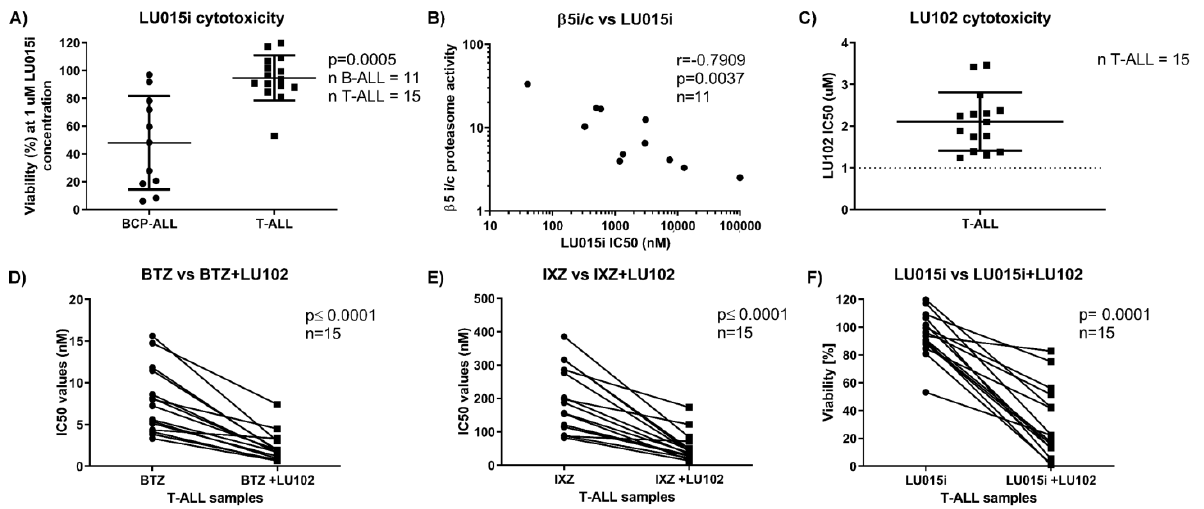
Figure 3. Cytotoxicity of subunit-selective proteasome inhibitors in BCP-ALL and T-ALL and correlation with immunoproteasome activity. ( A ) Comparison of the cytotoxicity of LU015i between BCP-ALL and T-ALL samples, p was obtained with Mann–Whitney U test. ( B ) Correlation between the ratio of activity of proteasome β 5i versus β 5c, determined by ABPs, and cytotoxicity of LU015i in BCP-ALL, expressed as individual IC 50 values. r and p were obtained with Spearman’s correlation. ( C ) IC 50 values of LU102 in T-ALL samples. ( D ) Paired comparison of IC 50 values of BTZ alone or combined with fixed dose of LU102 (1 µ M) determined 48 h after the continuous treatment in T-ALL. p was obtained with Wilcoxon’s paired test. ( E ) Paired comparison of IC 50 values of IXZ alone or combined with fixed dose of LU102 (1 µ M) determined 48 h after the continuous treatment in T-ALL. p was obtained with Wilcoxon’s paired test. ( F ) Cell viability (normalized to untreated control cells as 100%) in T-ALL after 48 h treatment with 1 µ M LU015i alone or in combination with 1 µ M LU102. p was obtained with Wilcoxon’s paired test. BTZ = bortezomib, IXZ = ixazomib, LU102 = a β 2 selective inhibitor, LU015i = a β 5i selective inhibitor, BCP-ALL = B-cell precursor acute lymphoblastic leukemia, T-ALL = T-lineage acute lymphoblastic leukemia, i = immunoproteasome, c = constitutive